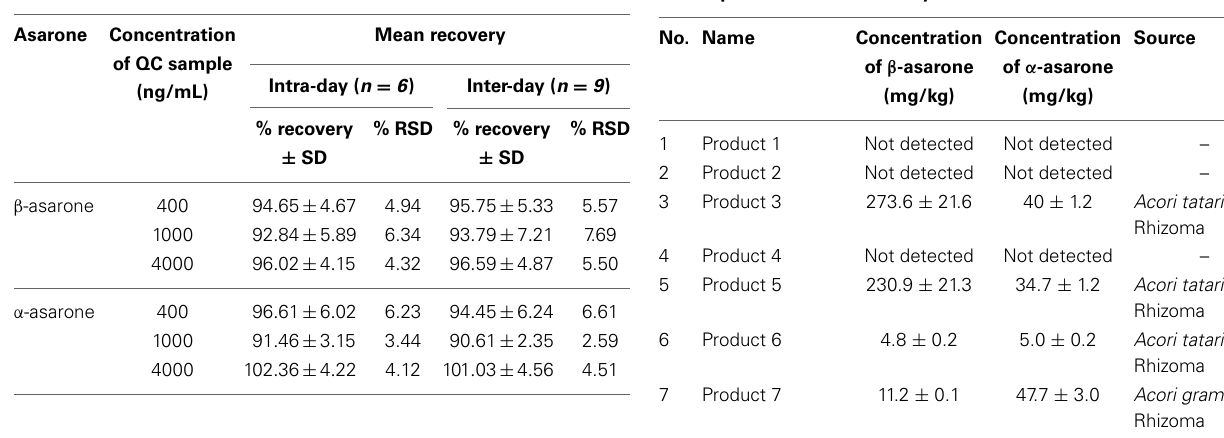
Table 2 | Absolute recoveries or extraction efficiency of asarones from the herb A. tatarinowii .